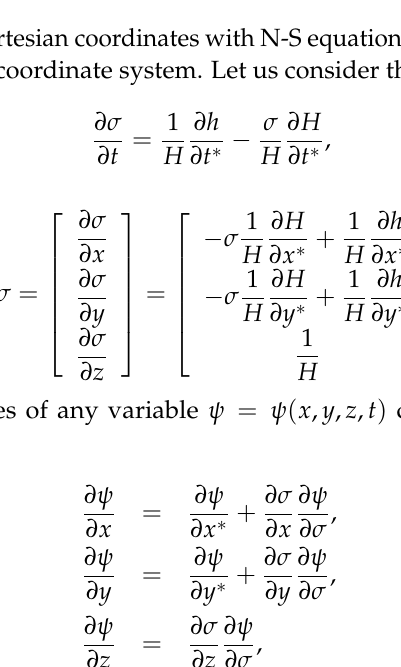
Figure 3. Physical domain and parameters used in σ -transformation with free surface and bed evolution in the Cartesian coordinate